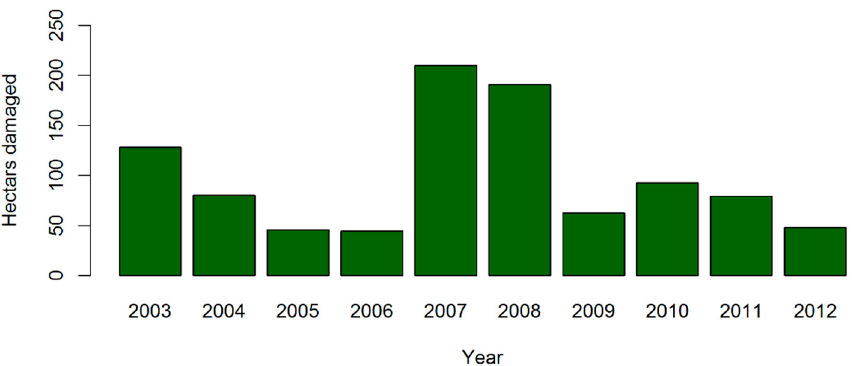
Figure 2. Size of forest damaged areas in the study region (calculated from classified LANDSAT images).